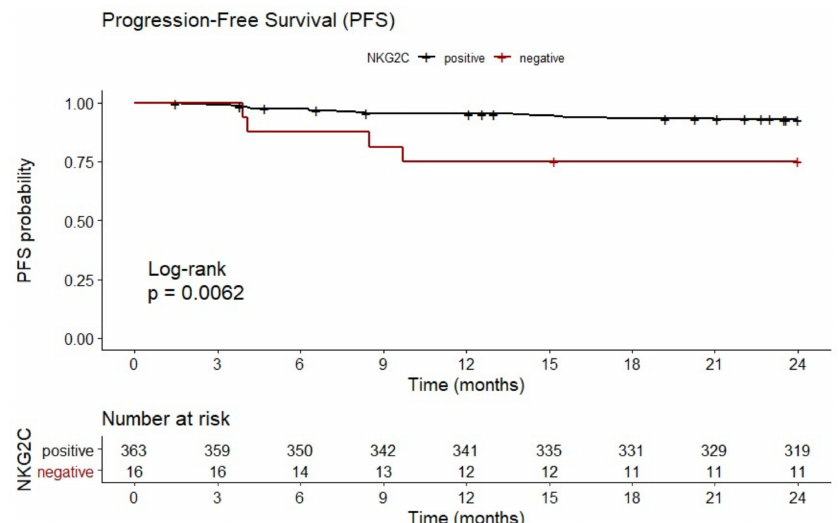
Figure 2. Reduced 2-year progression-free survival (PFS) in patients with NKG2C − / − . B-NHL patients with homozygous deletion of NKG2C showed a reduced 2-year PFS compared to NKG2C positive patients. NKG2C − / − (negative, red); NKG2C +/ − or NKG2C +/+ (positive, black). Data were not available for the total number of patients due to loss of follow up.